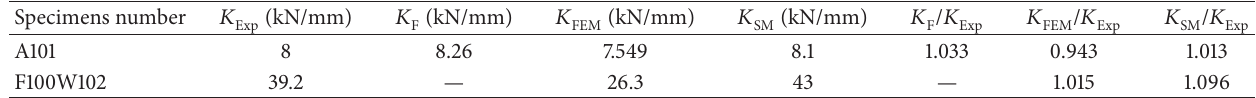
Table 4: Comparison of the initial stiffness.